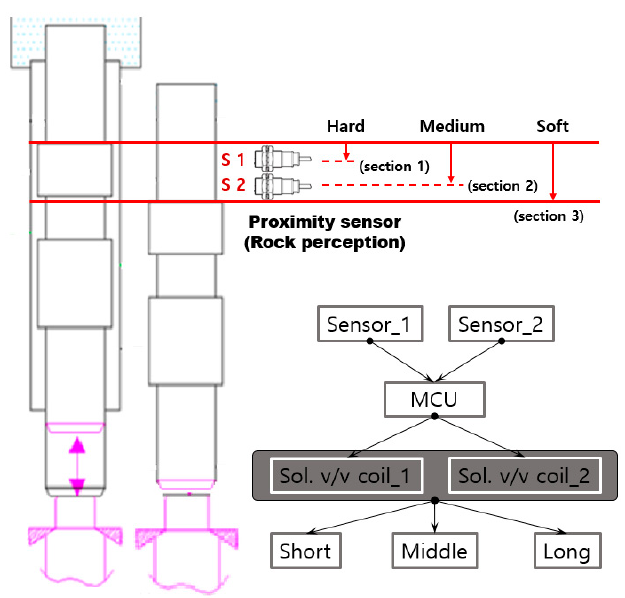
Figure 7. Schematic diagram of the control system logic.